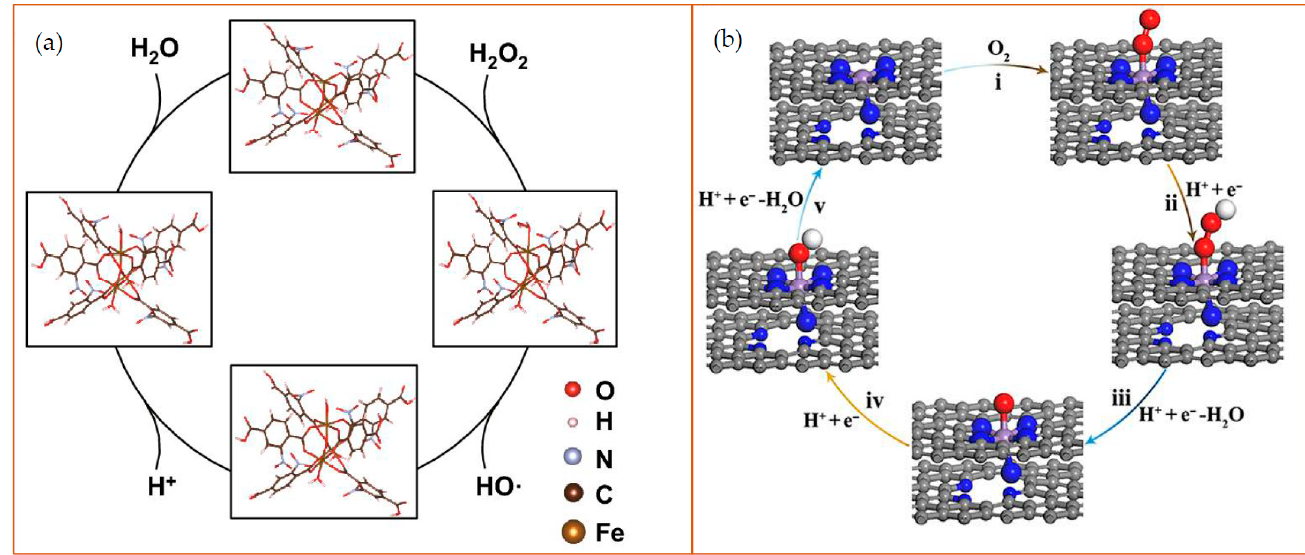
Figure 5. Examples of the catalytic mechanism of MOFs. ( a ) Schematic diagram of peroxidase-like reaction of NO 2 -MIL-101. in an acidic environment. In the MOFs, the Fe was employed at the reaction site to cleave H 2 O 2 into an • OH and a hydroxyl group (–OH). The hydrogen ions and –OH form H 2 O as a byproduct. Reprinted from ref. [65]; ( b ) Schematic diagram of oxidase-like nanozyme: carbon nanoframe–confined axial N-coordinated single-atom Fe (FeN5 SA/CNF). The pathways of O 2 reduction to H 2 O is a four-electron process on the nanozyme surface: (i) O 2 + H + + e − = OOH; (ii) OOH + H + + e − = O + H 2 O ; (iii) O + H + + e − = OH; (iv) OH + H + + e − = H 2 O. The color of the dots represent as follows: gray: C; blue: N; purple: Fe; red: O; white: H. Reprinted from [66] .